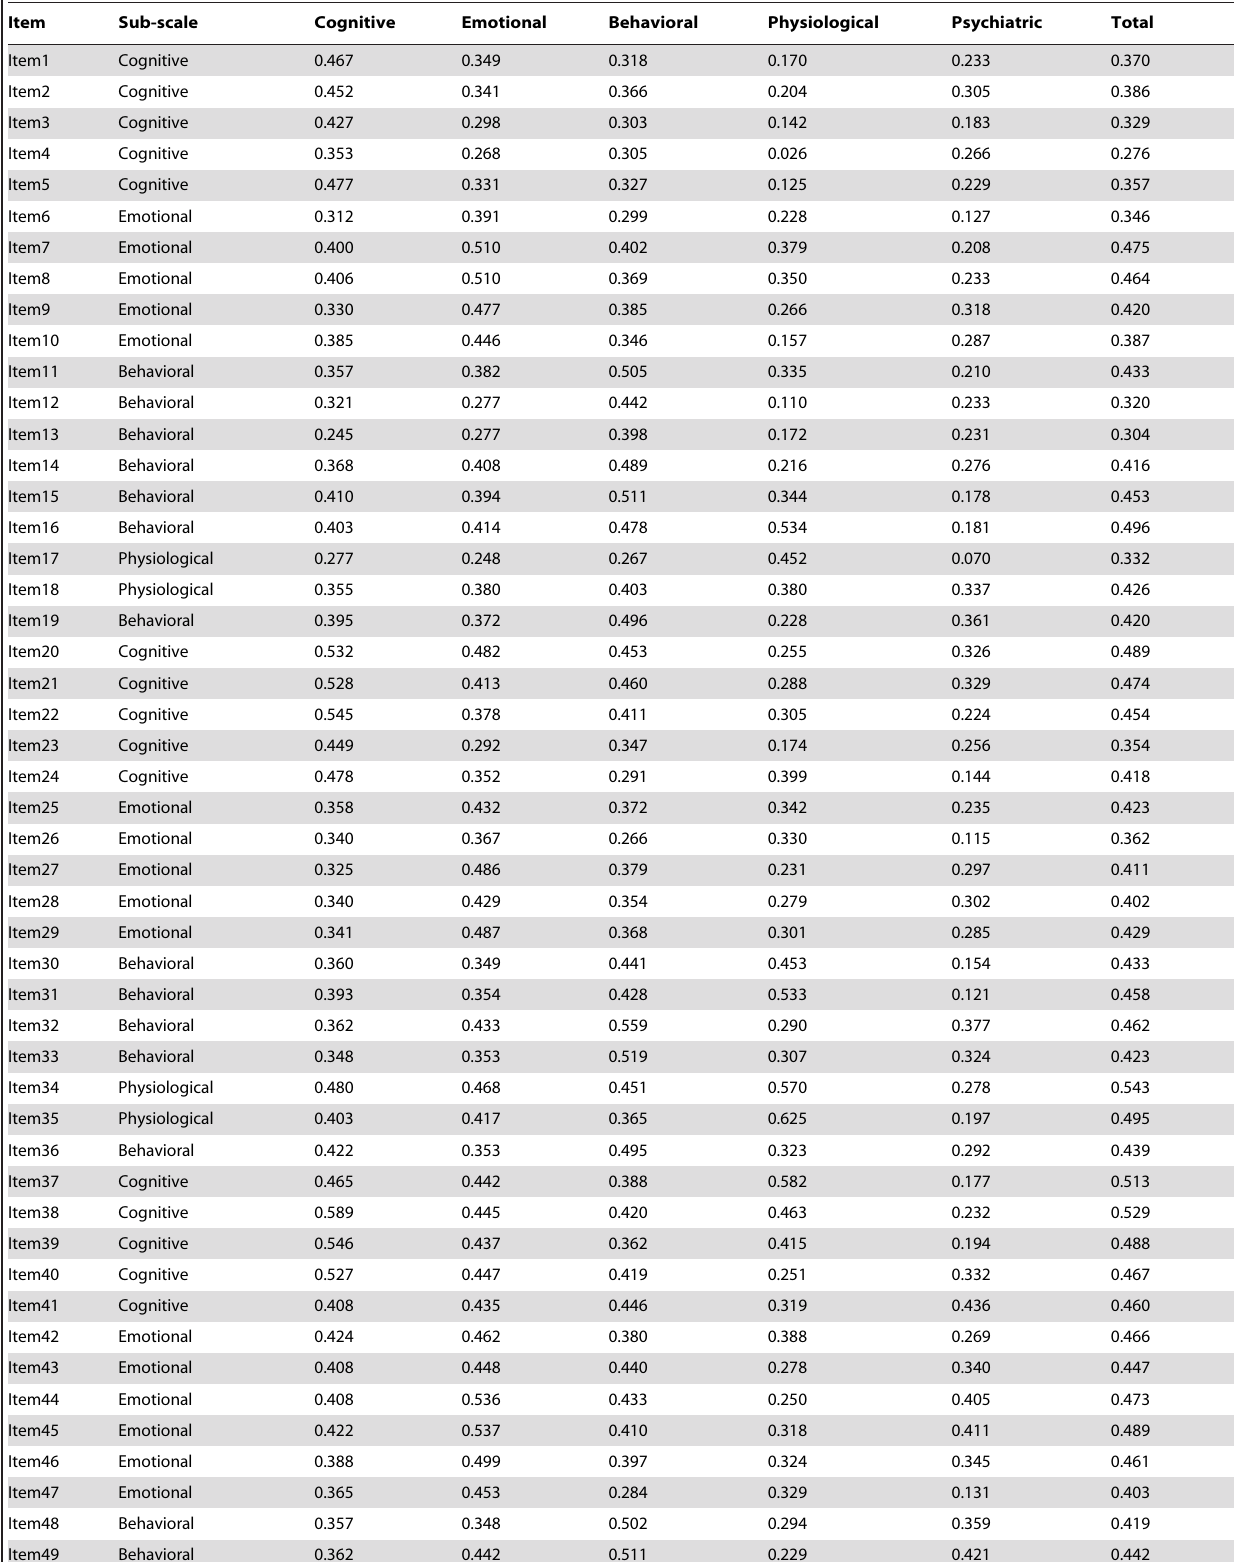
Table 2. Correlations between Items and ASRS